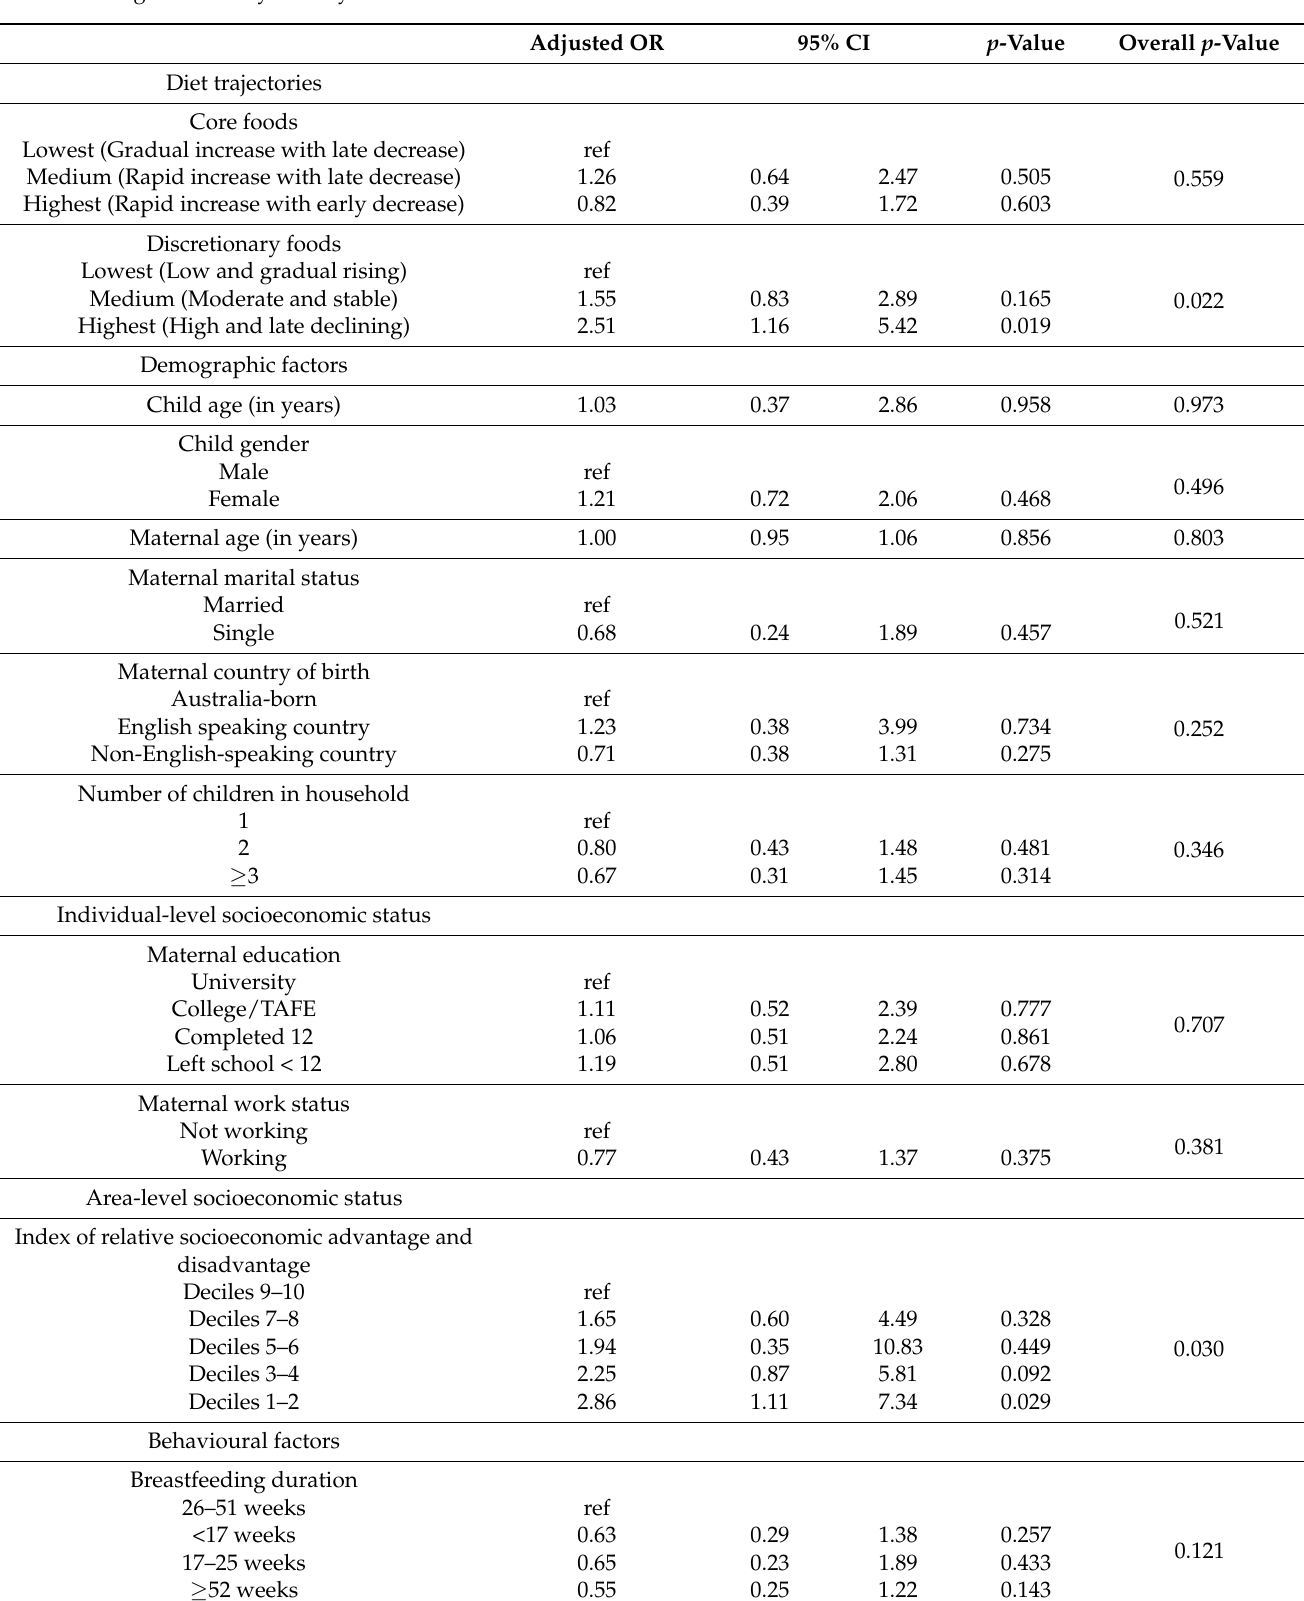
Table 3. Final model—impact of diet trajectories, demographic, socioeconomic, behavioural, and biological factors on overweight or obesity in early